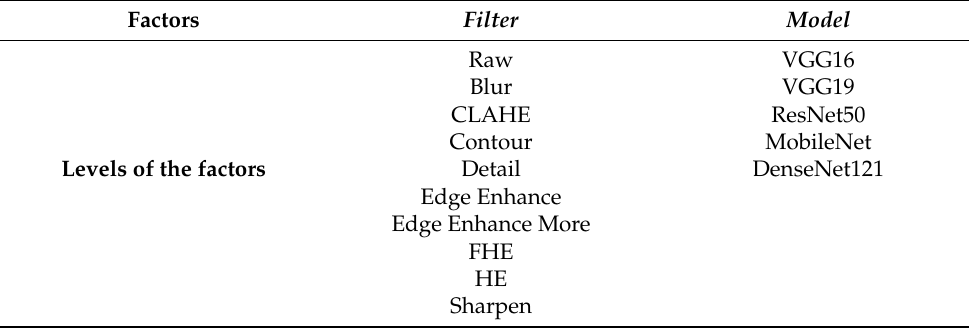
Table 5. Variables used in the statistical analysis. All the possible configurations of factors levels.